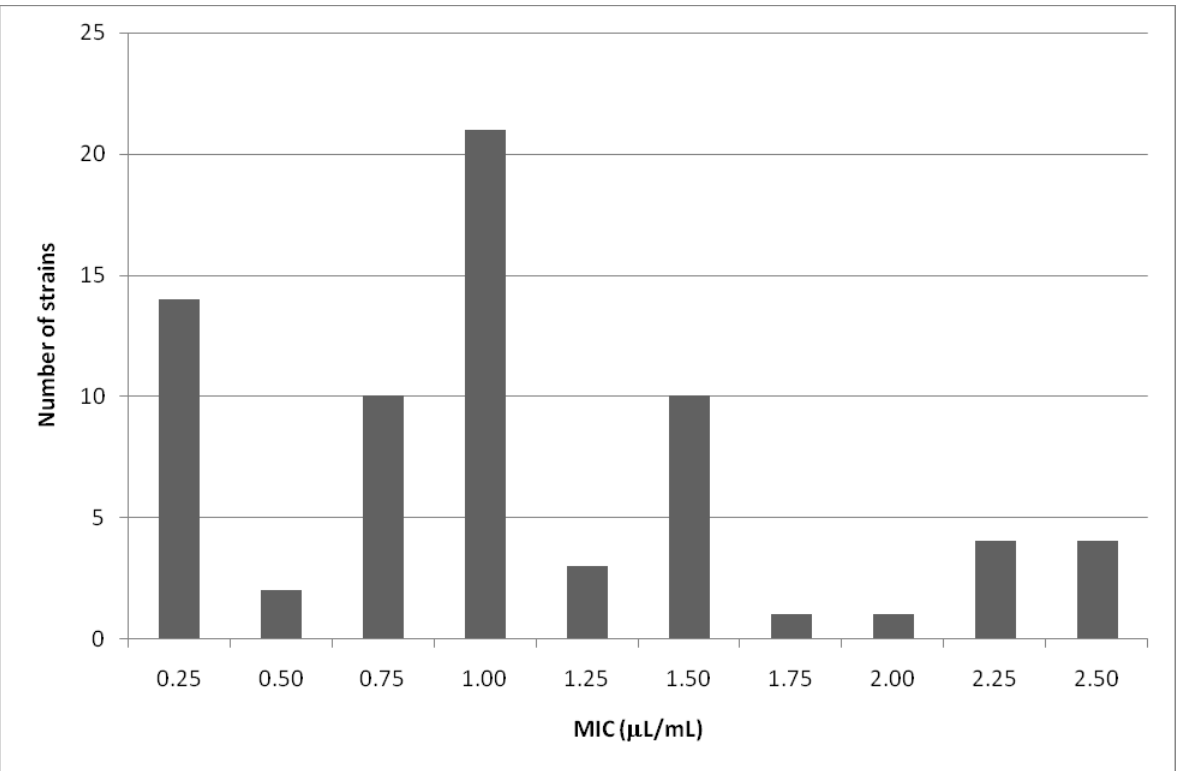
Figure 1. Susceptibility of the clinical S. aureus strains to the geranium